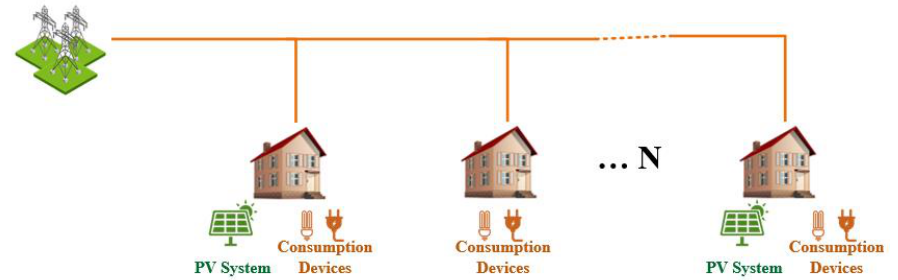
Figure 4. Scheme of energy community under study.